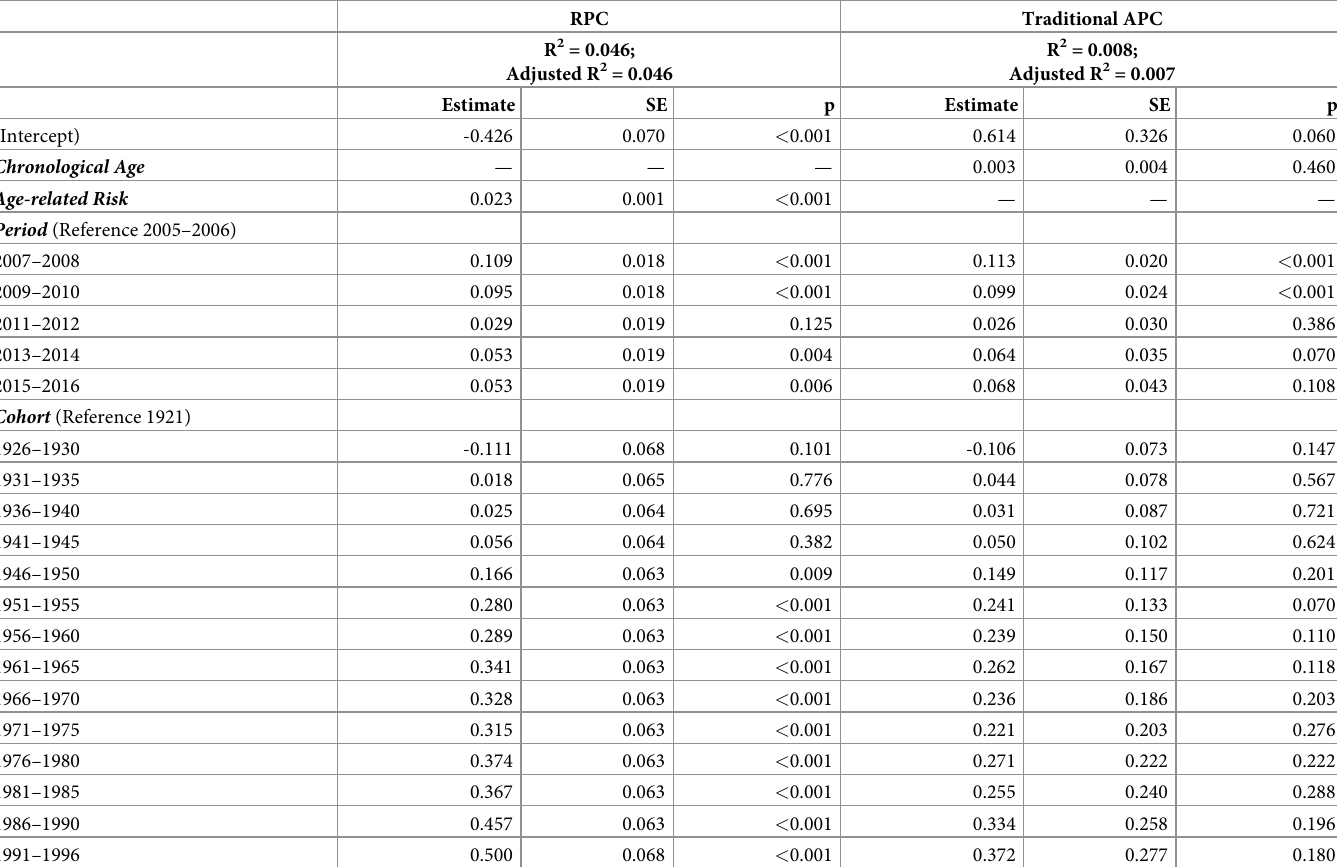
Table 4. Application of the RPC approach and a traditional APC approach on NHANES survey data to evaluate time-varying trends in depression screening from 2005–2016 (N = 27496).